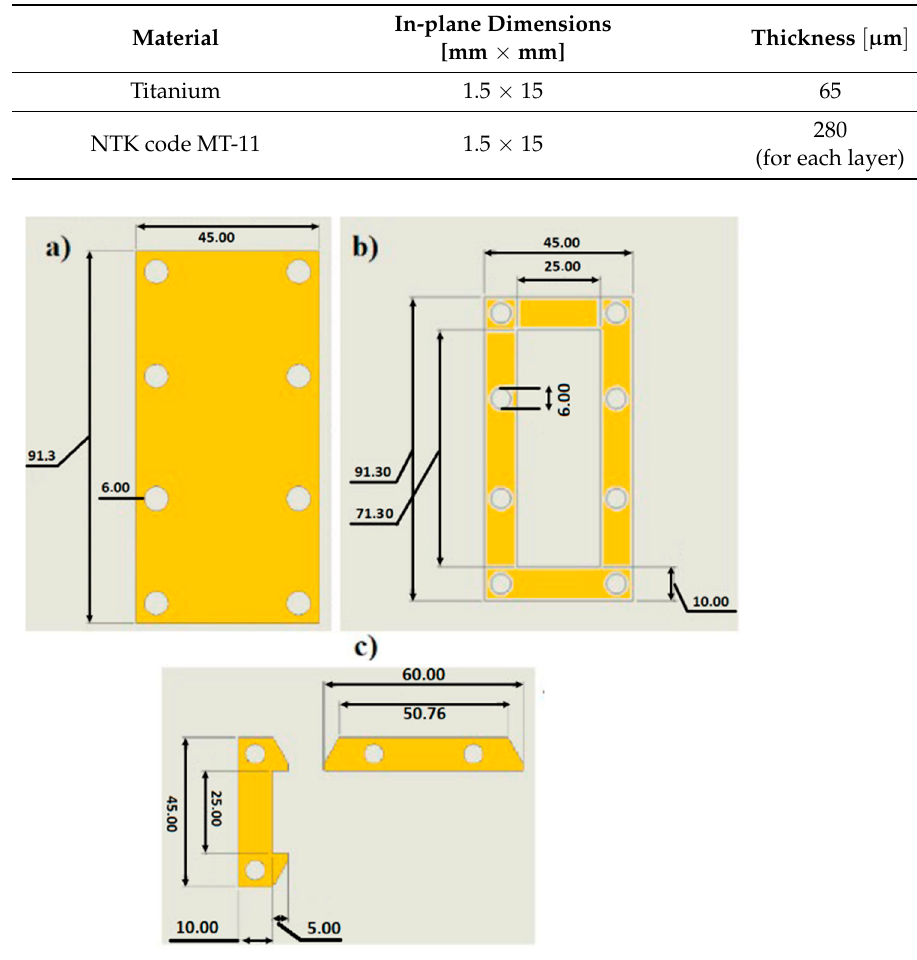
Figure 10. Components of the mechanical frame: ( a ) Base ( b ) Collar ( c ) Anchors. Dimensions are in mm.